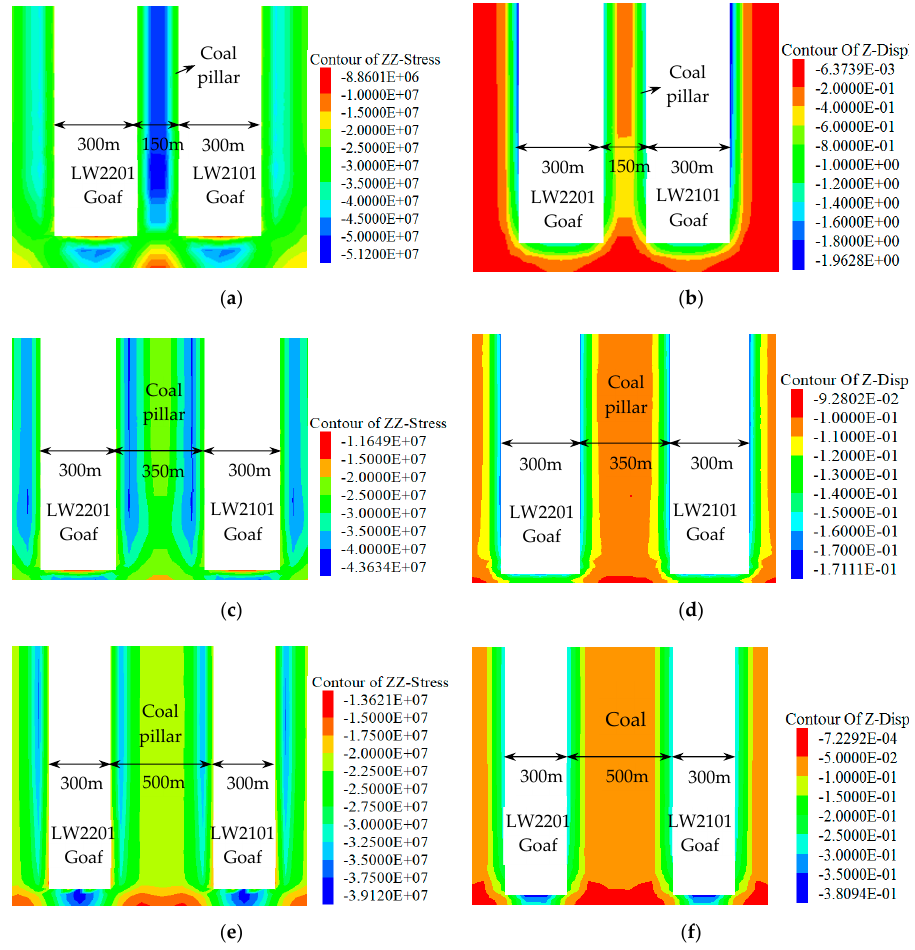
Figure 10. Characteristics of vertical stress distribution and compressive deformation amount of ICPs with different widths after mining on their two sides: ( a ) characteristics of vertical stress distribution above the 150 m wide coal pillar, ( b ) compressive deformation amount of the 150 m wide coal pillar, ( c ) characteristics of vertical stress distribution above the 350 m wide coal pillar, ( d ) compressive deformation amount of the 350 m wide coal pillar, ( e ) characteristics of vertical stress distribution above the 500 m wide coal pillar, and ( f ) compressive deformation amount of the 500 m wide coal pillar. Energies 2020 , 13 , x